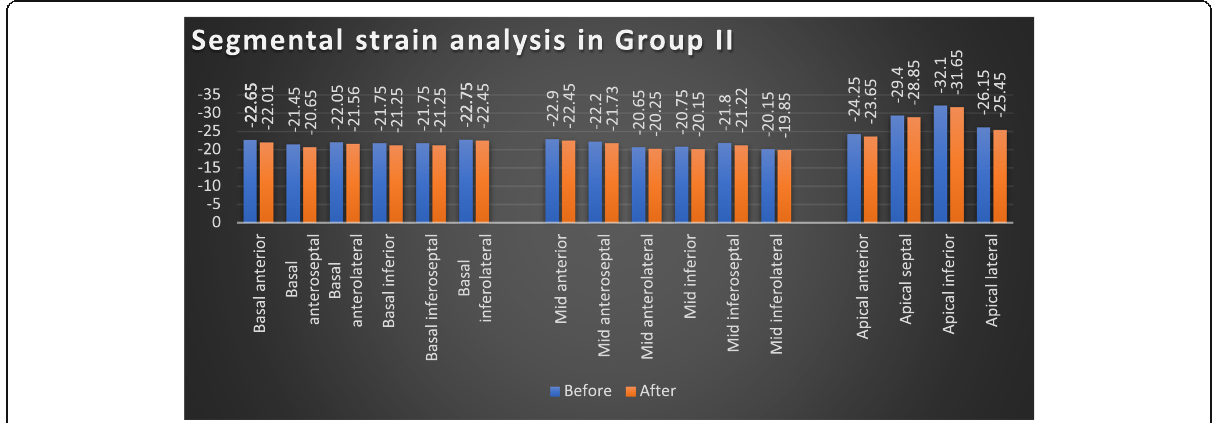
Fig. 2 Segmental strain analysis before and after receiving antiviral treatment in group II